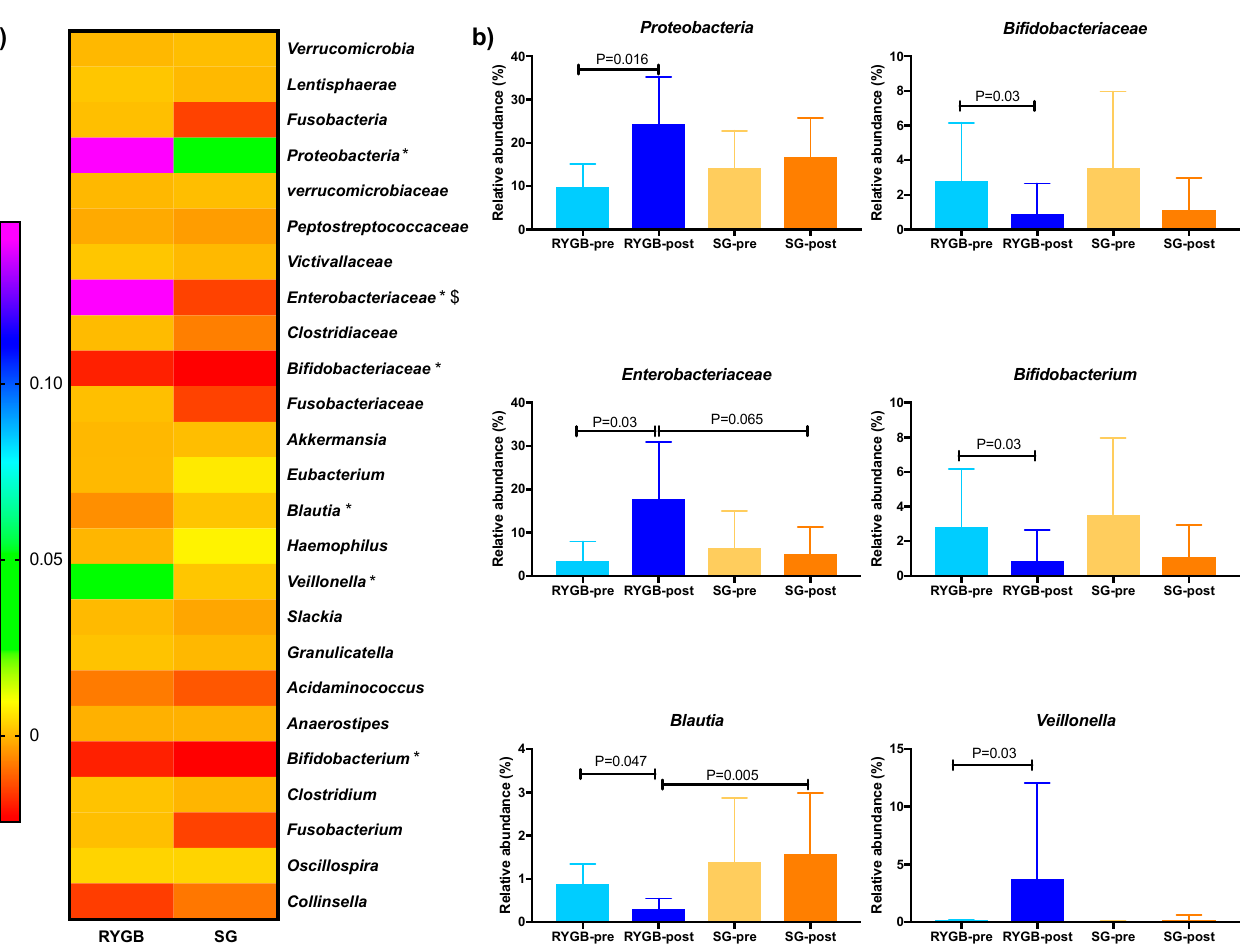
Figure 1. ( a ) Heatmap of the changes in the relative abundance of the microbiota profile at Phylum, Family and Genus levels of the two bariatric surgery procedures tested, Roux-en-Y gastric bypass (RYGB) and sleeve gastrectomy (SG). Differences in percentage are shown. * Indicates changes within the RYGB procedure, $ indicates changes between procedures. ( b ) Bar plots of the statistically significant bacteria from the previous heatmap.